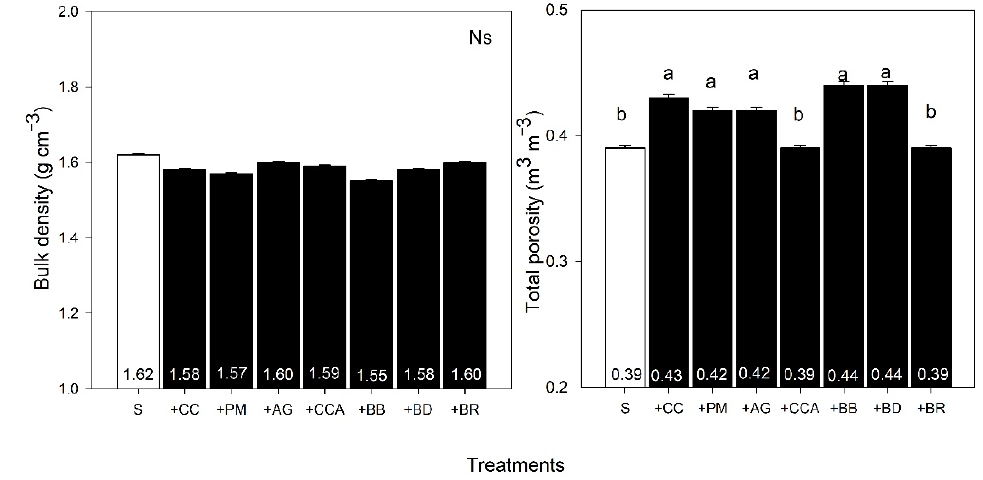
tween the digits into decimal dots.